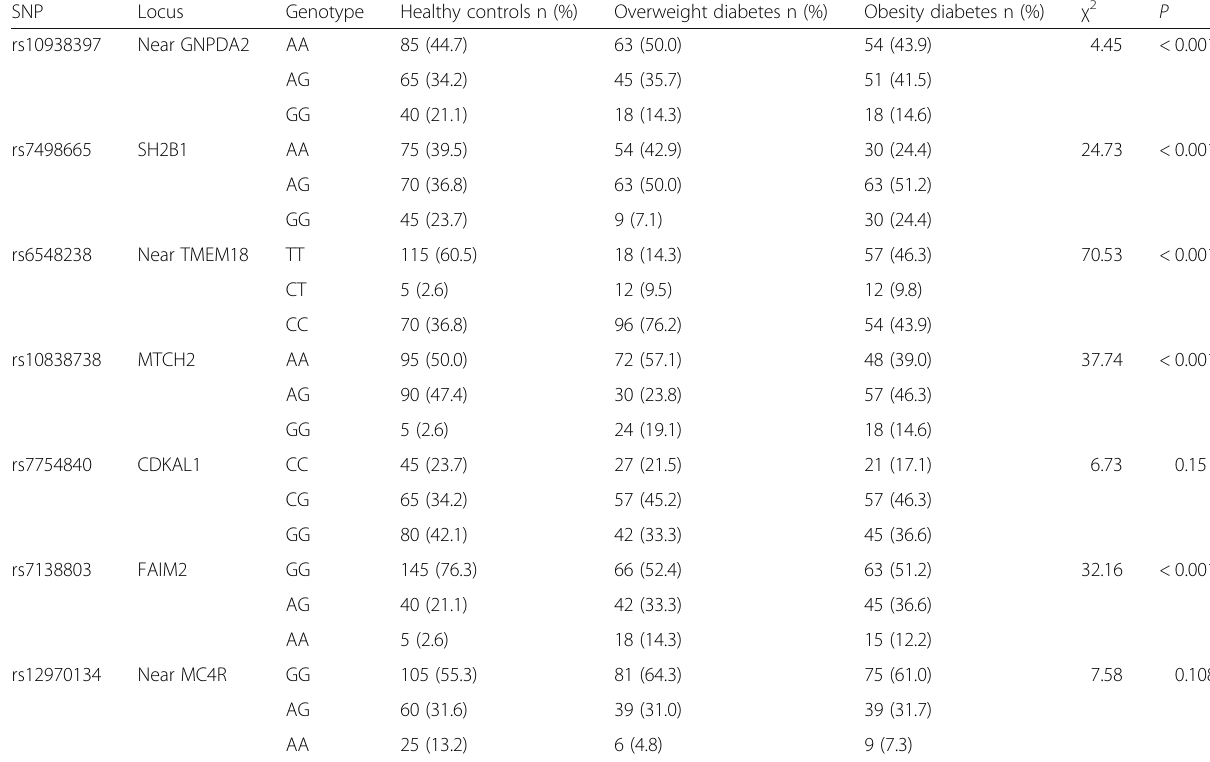
Table 4 Genotypes of seven genetic